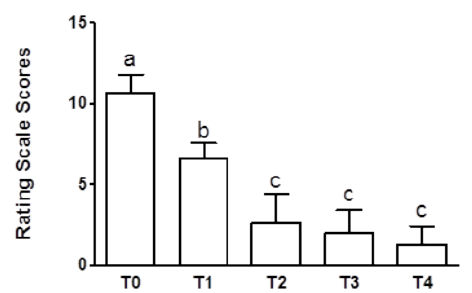
Figure 1. Rating scale scores (0–12) of aggressive dogs before treatment (T0), and after one (T1), two (T2), four (T3), and six (T4) months of fluoxetine treatment (T0 vs. T1 vs. T2-T4 = p < 0.001, n = 8). a, b, c: statistically significant differences are present among the values reported in the bar of the graph.